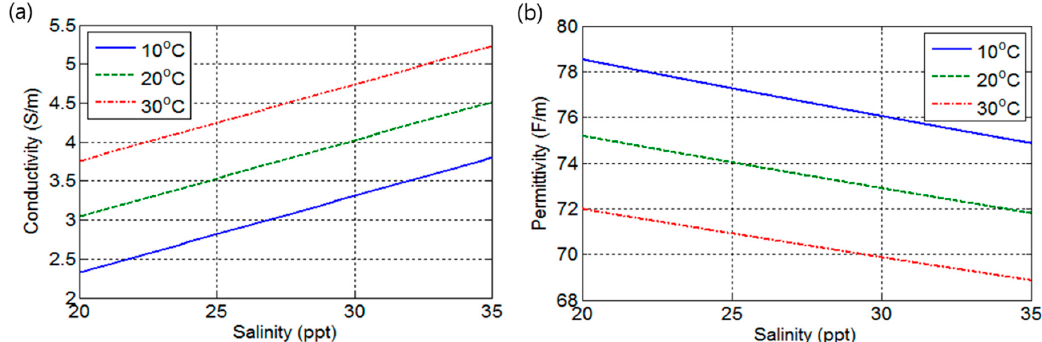
Figure 1 . ( a ) Conductivity of seawater according to salinity; ( b ) Permittivity of seawater according to salinity.